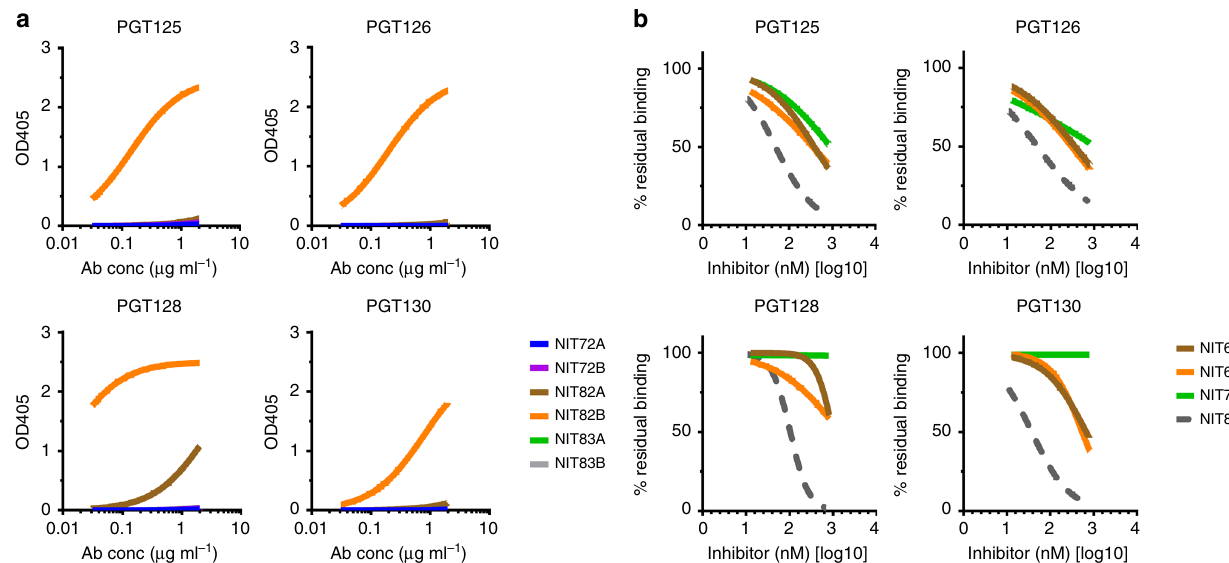
Fig. 3 NAbs PGT125, 126, 128, and 130 bind avidly to NIT82B, a neoglycoconjugate presenting an Rv3-derived mimic of oligomannose. a The listed conjugates are those from Fig. 2. The conjugates (69 – 72 kDa) were coated as solid-phase antigen onto ELISA plate wells at 5 µ g ml − 1 and assayed for recognition by PGT125, 126, 128, and 130 (starting at 2 µ g ml − 1 ). All antibodies were tested as IgGs. The data represent the means from two independent experiments, with error bars omitted for clarity. GraphPad Prism (version 7.02) was used to determined EC 50 values (0.1 – 5 nM). b To assess the importance of valency for antibody binding, conjugate NIT82B was coated onto ELISA plates (5 µ g ml − 1 ) and antibody binding assessed in the presence of the unconjugated 3-aminopropyl glycosides NIT68A (presented on NIT82A), NIT68B (presented on NIT82B) or NIT70A (presented on NIT83A), or the NIT82B glycoconjugate as a comparator (dashed line). The results, obtained from one experiment, show that the antibodies are inhibited best by